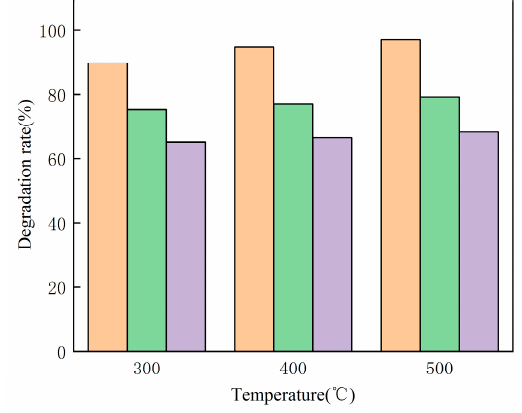
Figure 7. Regeneration experiment.